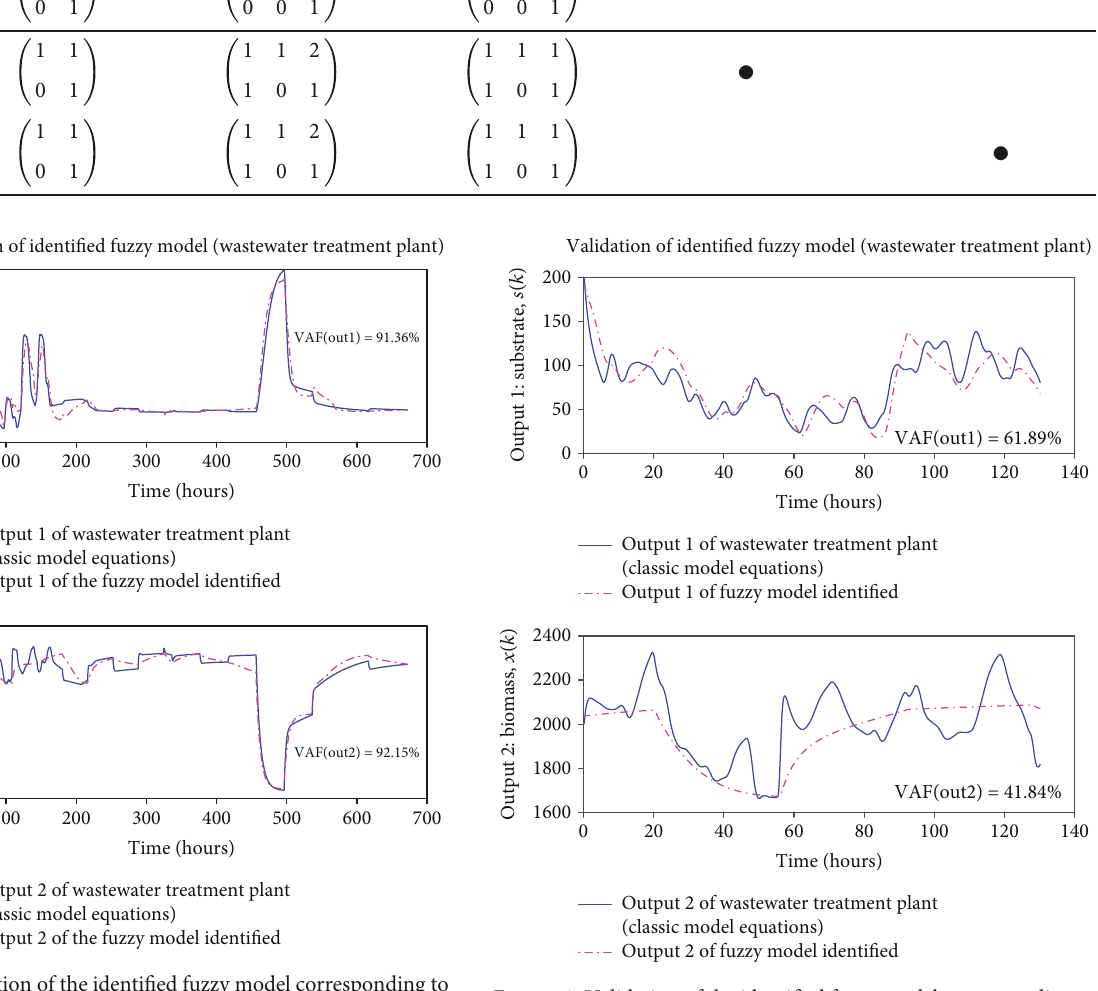
Figure 8: Validation of the identi fi ed fuzzy model corresponding to case B for output 1, s k , and output 2, x k